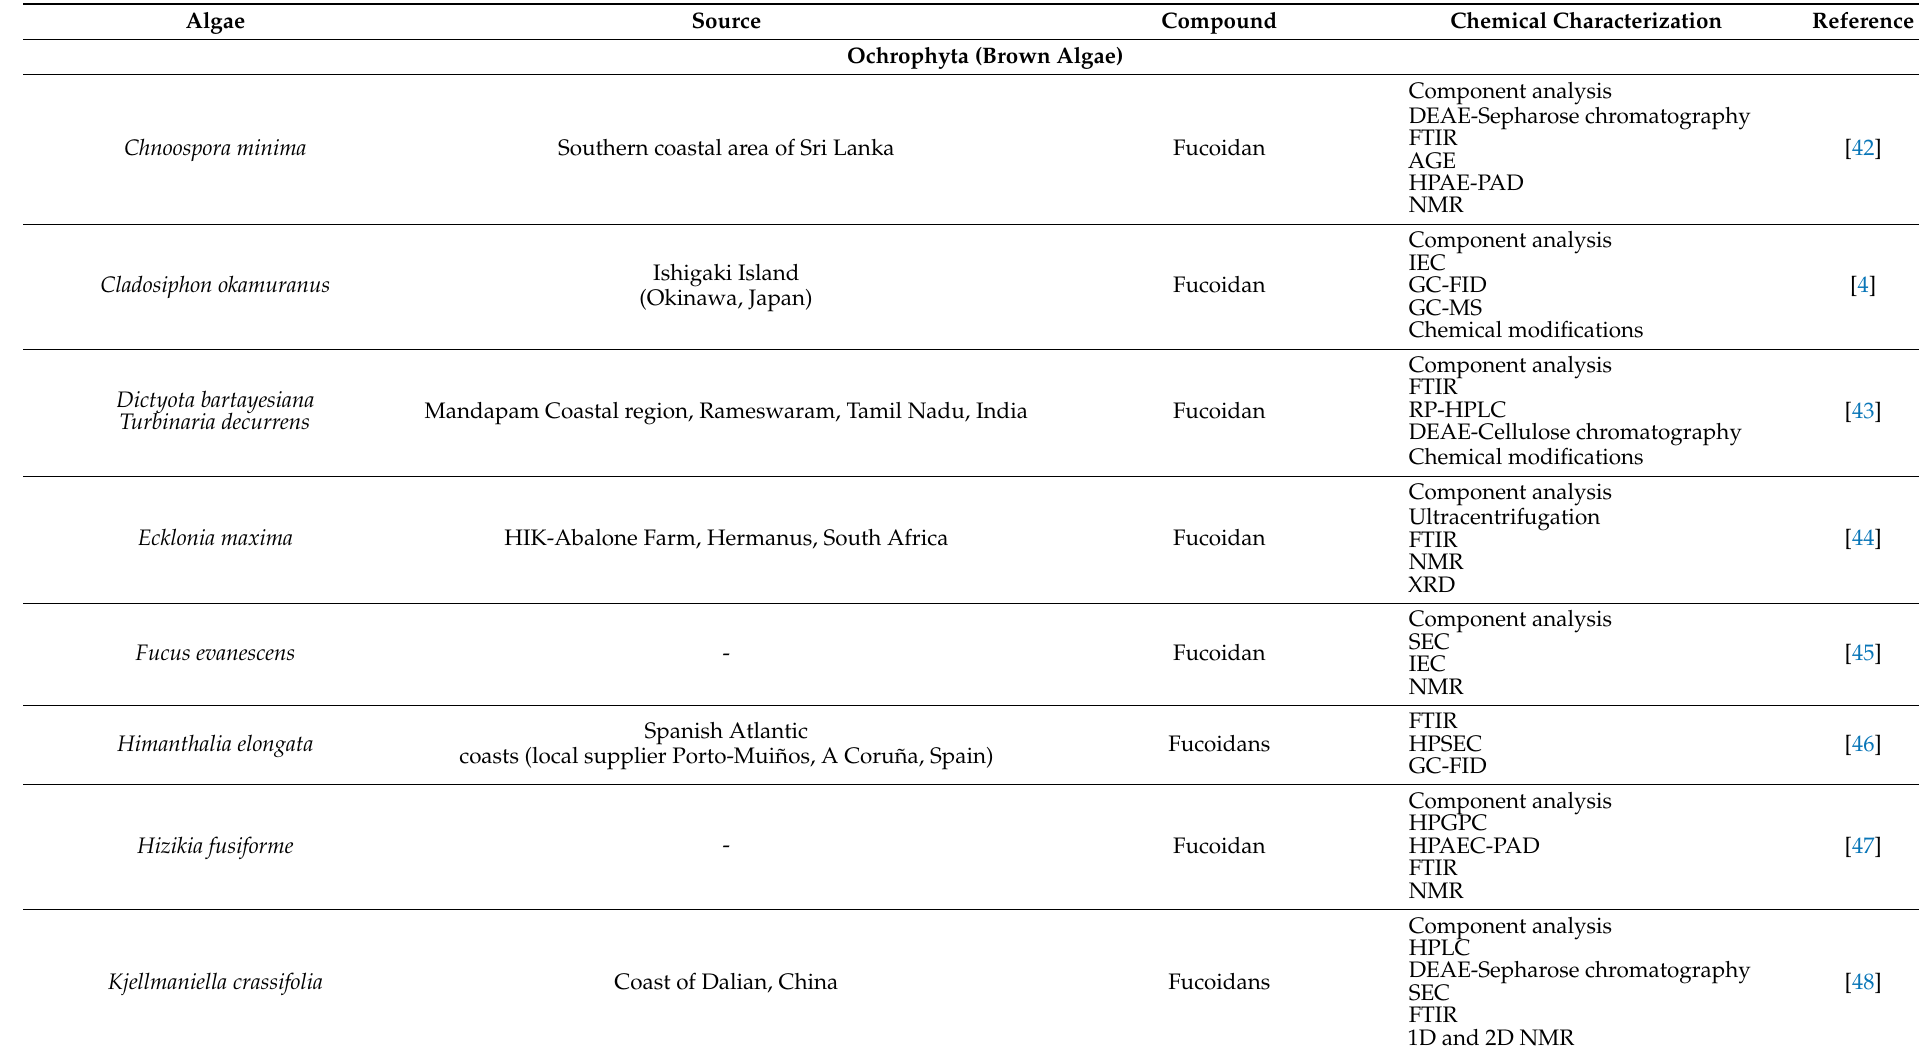
Table 1. Strategies for chemical characterization of sulfated polysaccharides isolated from macroalgae adopted in the last five years